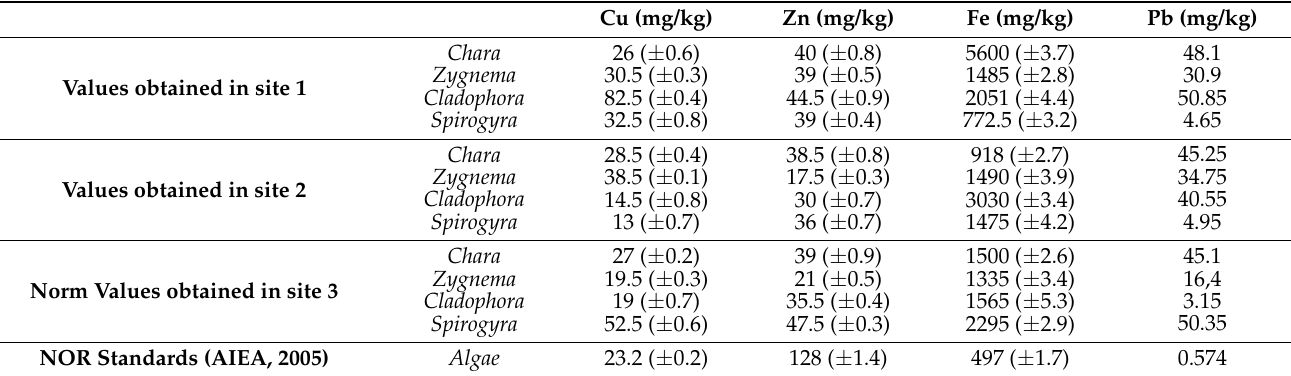
Table 1. Comparison of the values obtained with the limit values (International standards accepted by (IAEA,